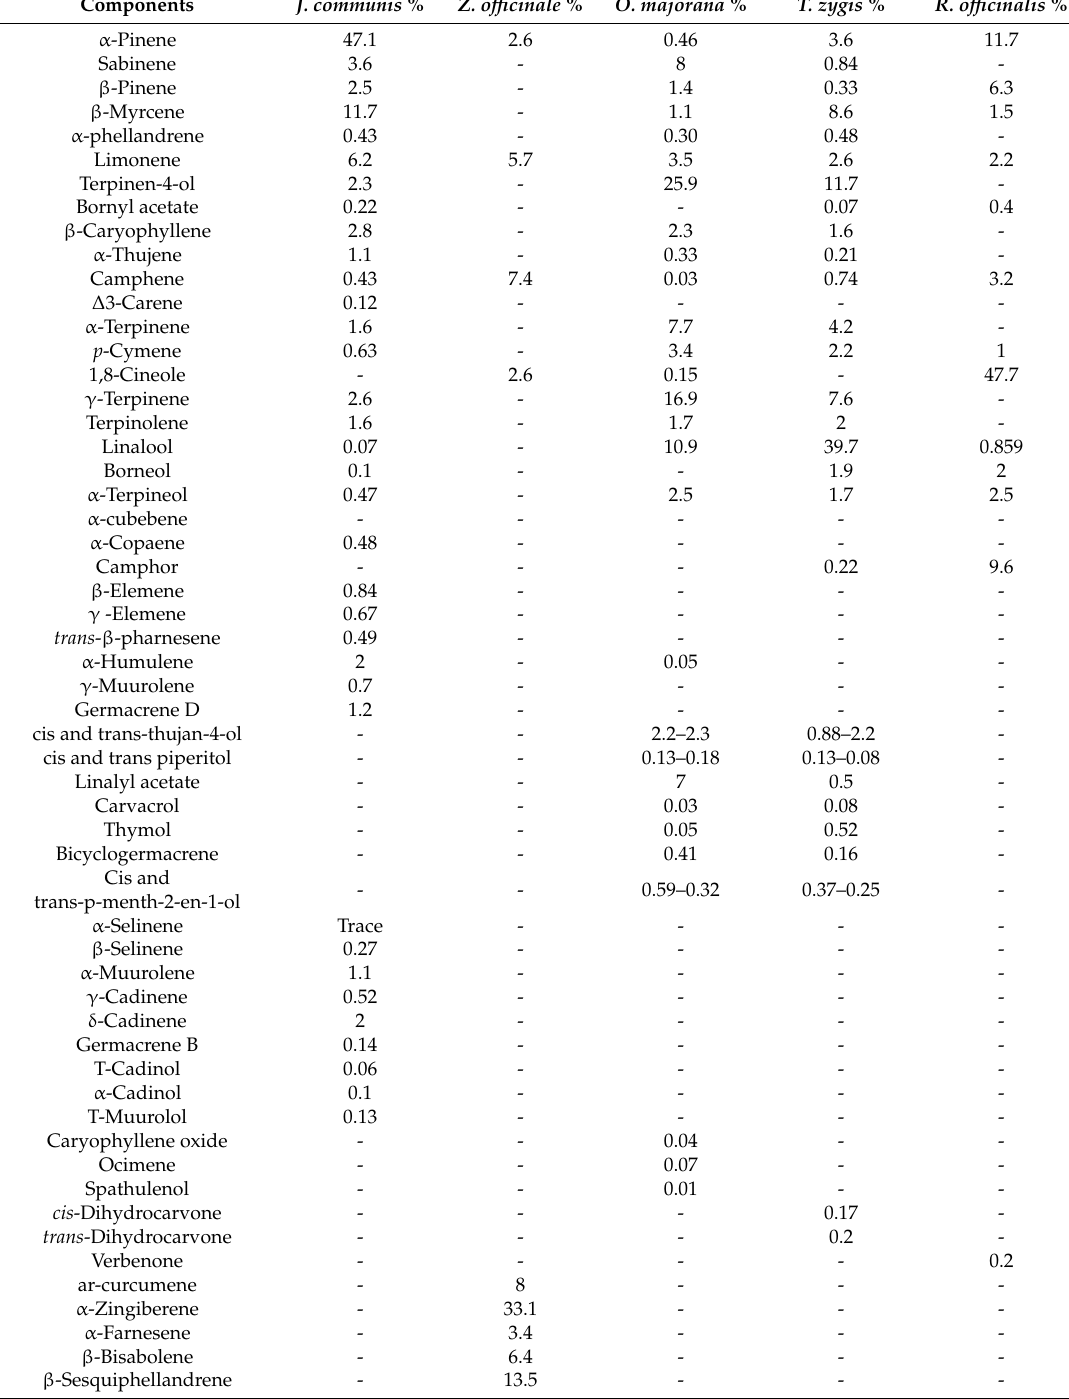
Table 1. Chemical composition of the essential